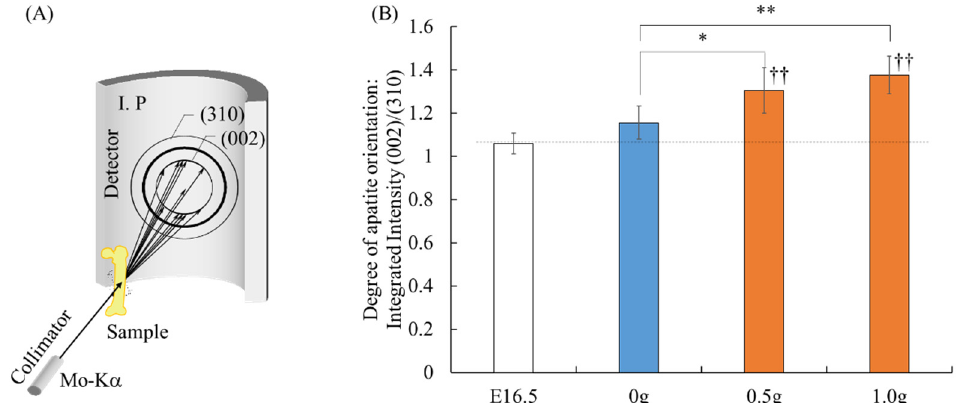
Figure 3. Analysis of apatite orientation: ( A ) Schematic illustration of the apatite orientation measurement using transmission micro-beam XRD method. The preferential orientation of the c -axis of apatite crystals was analyzed with the integrated intensity ratio of (002)/(310). ( B ) Quantitative analysis of apatite orientation along the longitudinal direction of the bone before cultivation (E16.5) and after 7 days of cultivation. * p < 0.05, ** p < 0.01. †† p < 0.01 vs. E16.5.